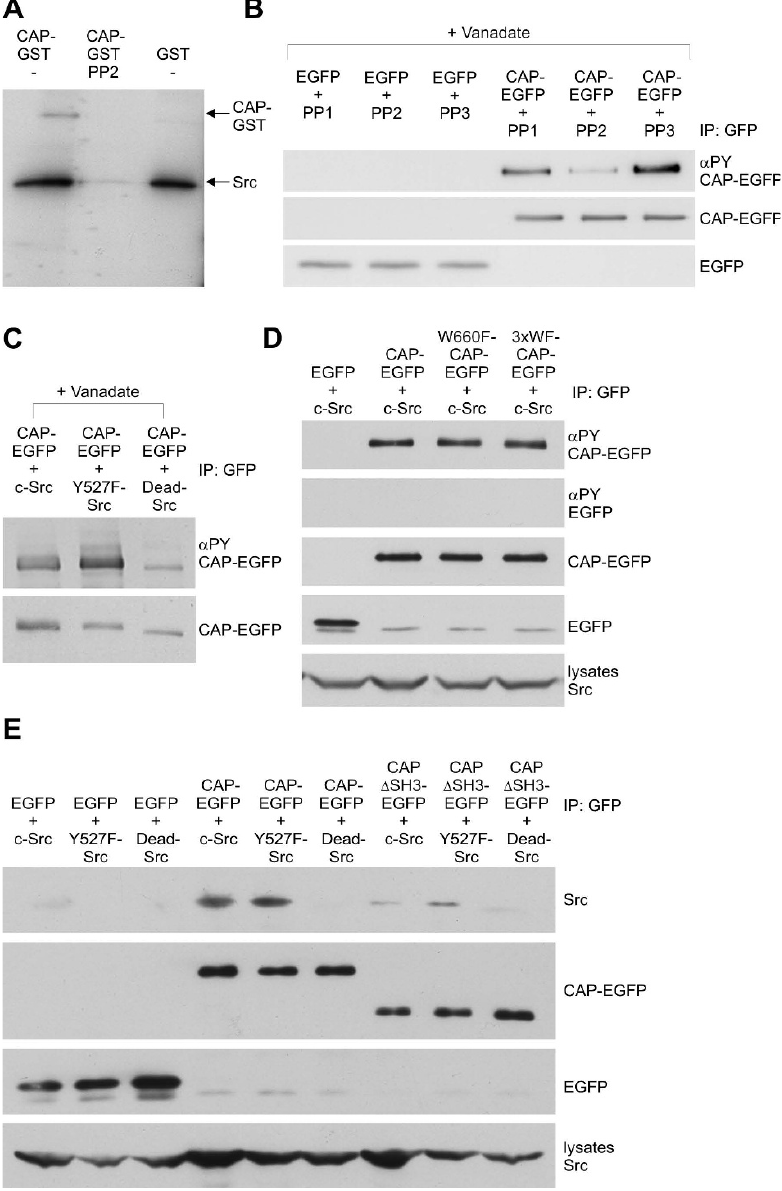
Figure 6 CAP is a substrate of Src kinase . A: Purified CAP-GST or GST was incubated with recombinant, purified Src kinase and [ γ - 32 P]-ATP, run into SDS-PAGE gel and analyzed by autoradiography. Specific phosphorylation of CAP-GST could be detected after incubation with active Src but not after inhibition of Src activity with PP2. Autophosphorylation of Src was used as an internal control for successful inhibition. B: CAP-EGFP or EGFP were immunoprecipitated from cells treated with vanadate and either Src inhibitors PP1 or PP2 or a non-inhibiting analogue PP3. Inhibition of endogenous Src activity clearly reduced the Tyr phosphorylation of CAP-EGFP. C: Coexpression of active forms of Src kinase (c-Src or Y527F-Src) notably increased the Tyr- phosphorylation of CAP-EGFP as compared to cells coexpressing the inactive Src mutant (Dead-Src). D: Intact SH3 domains of CAP are not necessary for the phosphorylation of CAP by Src. CAP-EGFP or CAP mutants carrying mutations in the SH3 domains were coexpressed and the phosphorylation of CAP was studied after immunoprecipitation. Mutation of the critical tryptophane in the third SH3 domain (W660F-CAP-EGFP) or in all three SH3 domains (3xWF-CAP-EGFP) exhibited no effect on the degree of Tyr phosphorylation of CAP by Src. E: Active forms of Src (c-Src and Y527F-Src) were coprecipitated with WT CAP and to a severely reduced degree with the Δ SH3 mutant of CAP, whereas kinase dead Src did not associate with either the WT or Δ SH3